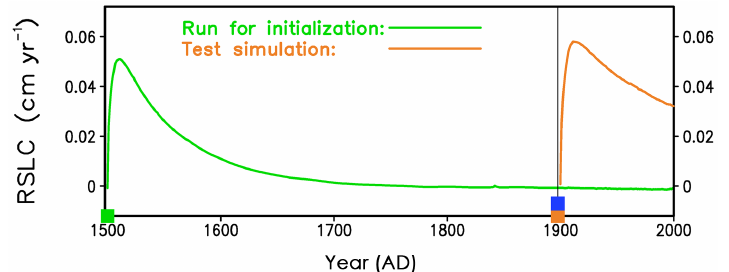
Figure 4. Time series of the rate of sea level change produced by the GrIS, illustrating the impact of the timing of the last two switches during the initialization. The green curve is from the simulation used for initialization of our future projections, which switches from the shallow ice approximation to the hybrid mode at the year 1500 (green square). The orange curve is from a test simulation (not used for initialization of our future projections), where we switch from the shallow ice approximation to the hybrid mode at the year 1900 (orange square). Both simulations switch from relaxing surface to free surface at the year 1900 (blue square), i.e. for the test simulation, the two switches appear at the same